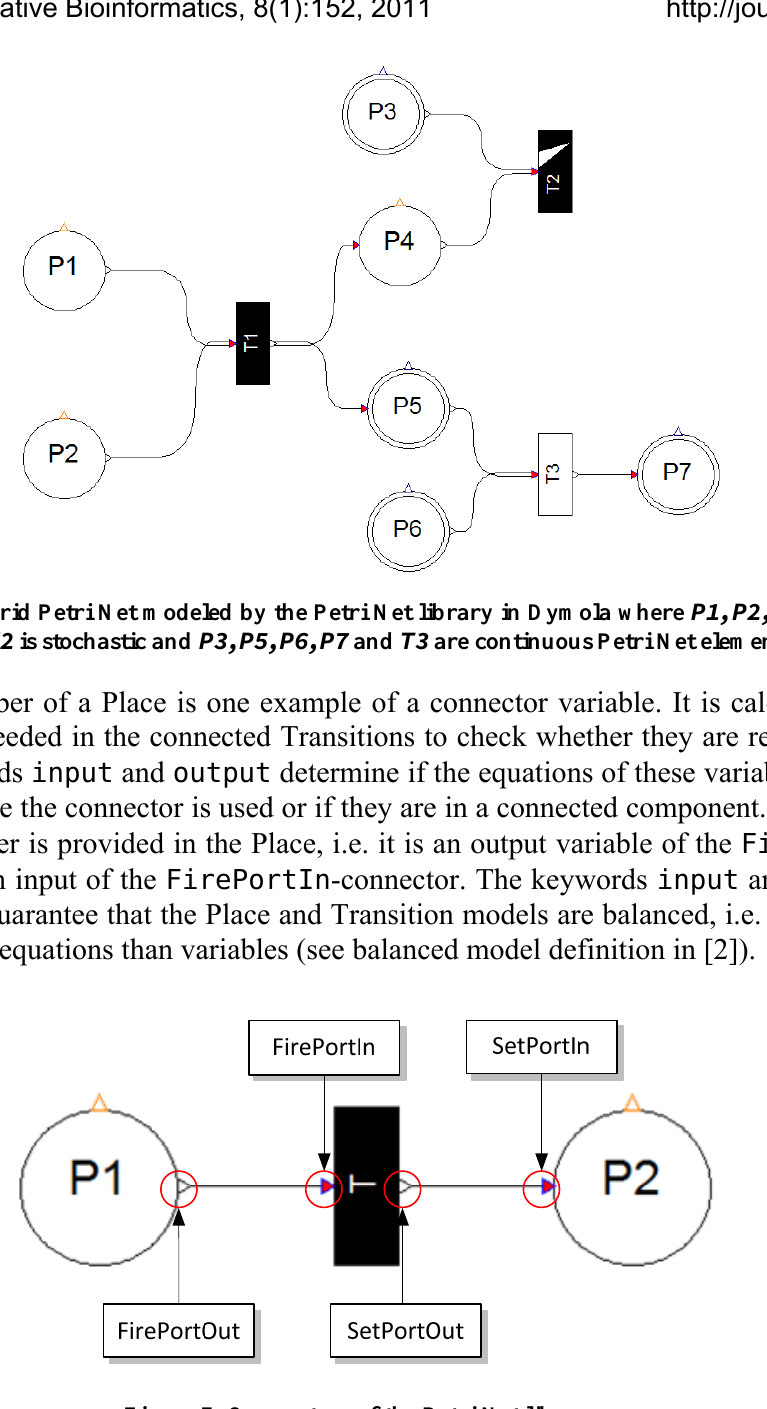
Figure 7: Connectors of the Petri Net